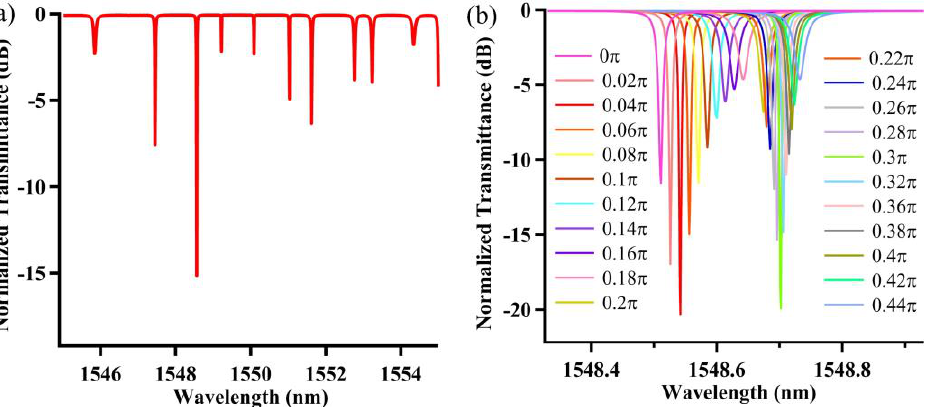
Figure 2. ( a ) Calculated transmission spectrum for the gourd-shaped resonator system, and ( b ) spec- trum variation aroused by the additional phase change in the U-shaped pathway with coupling coefficients 𝑐 𝑟1 = 0.9 and 𝑐 𝑟2 = 0.6.